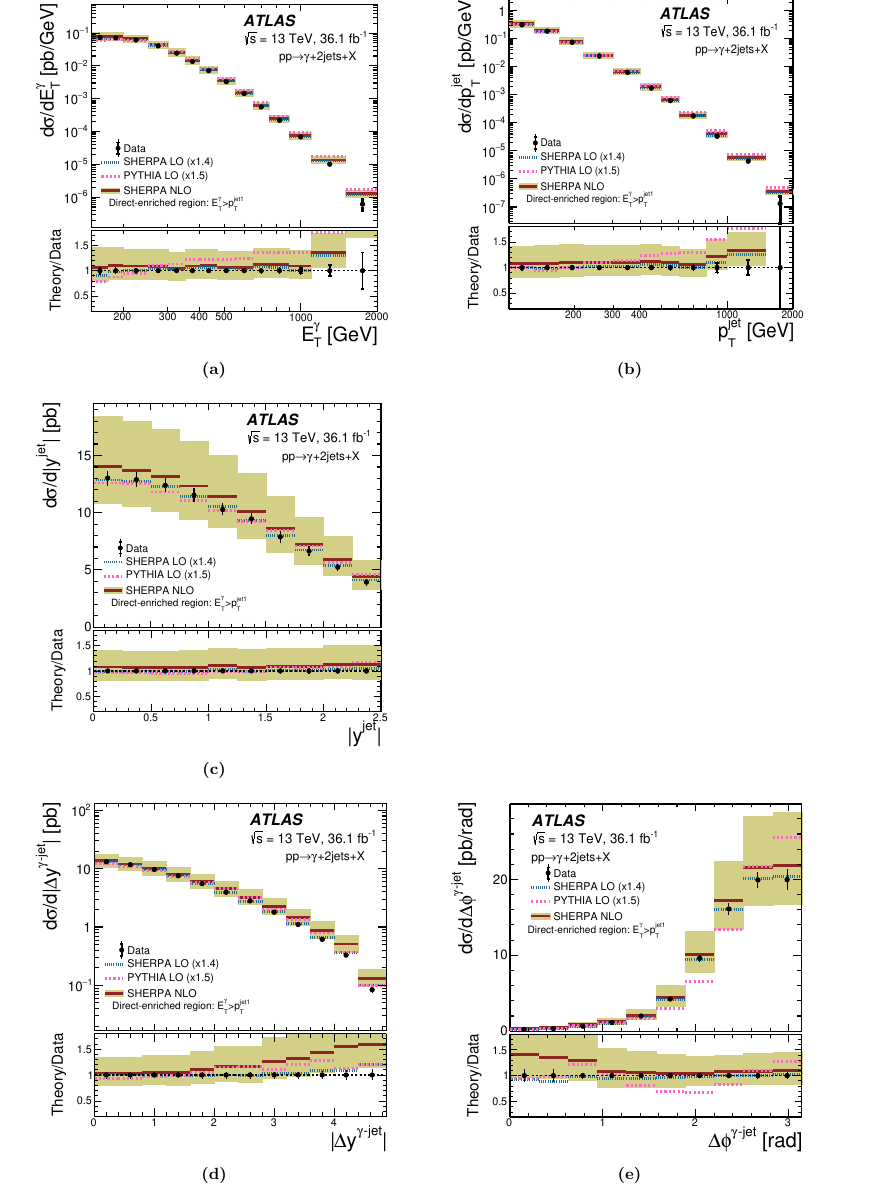
Figure 8 . Measured cross sections for isolated-photon plus two-jet production (dots) as functions of (a) E (cid:13) , (b) p jet , (c) j y jet j , (d) j (cid:1) y (cid:13) {jet j and (e) (cid:1) (cid:30) (cid:13) {jet for the direct-enriched phase space. T T The NLO QCD predictions from Sherpa (solid lines) based on the NNPDF3.0 PDFs are also shown. The tree-level plus parton-shower predictions from LO Sherpa (dotted lines) and Pythia (dashed lines) normalised to the integrated measured cross section (using the factors indicated in parentheses) are also shown. The bottom part of each (cid:12)gure shows the ratio of the predictions to the measured cross section. The inner (outer) error bars represent the statistical uncertainties (the statistical and systematic uncertainties added in quadrature) and the (cid:12)lled bands represent the theoretical uncertainty of the NLO QCD predictions. For most of the points, the inner and outer error bars are smaller than the marker size and, thus, not visible. The visible thin error bars represent the outer error bars.